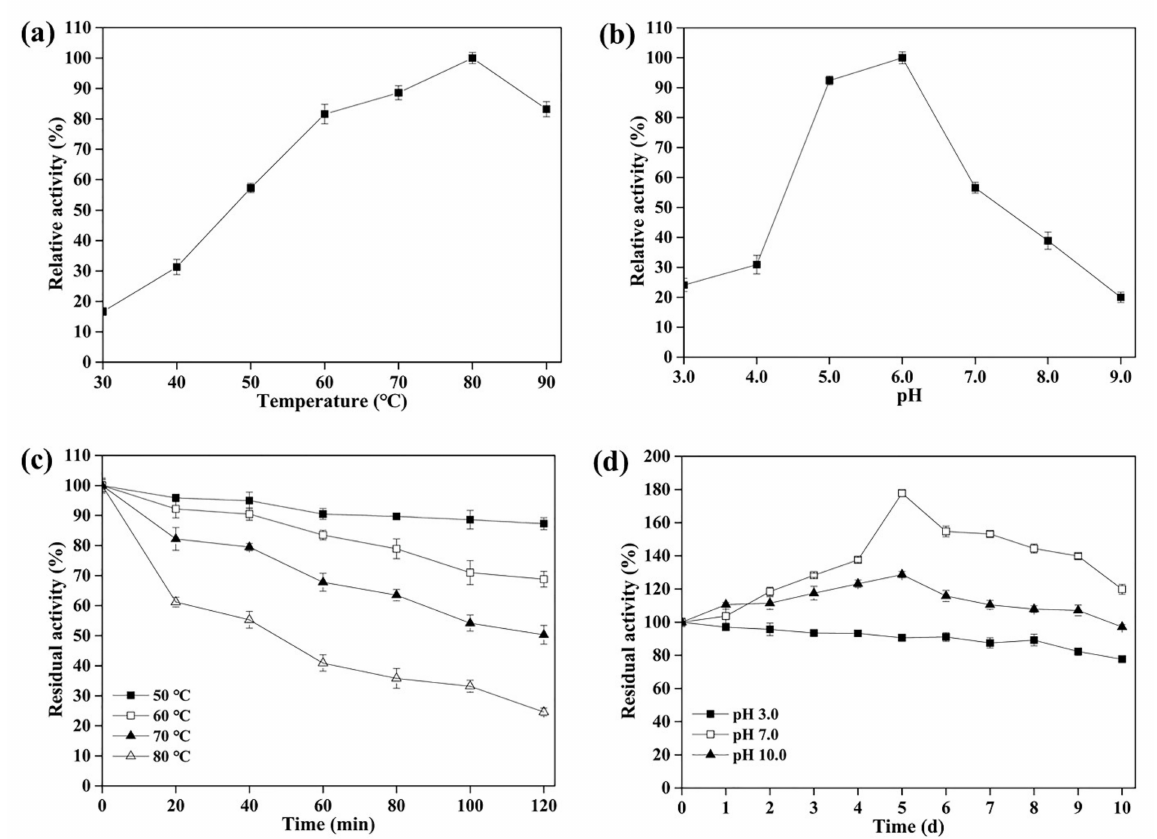
Figure 2. Effects of temperature or pH on the purified rLAC. ( a ) The laccase activity was recorded at different temperatures (30–90 ◦ C) and ( b ) pH values. ( c ) The thermostability of rLAC was evaluated through monitoring the residual activity after incubation at 50 ◦ C, 60 ◦ C, 70 ◦ C, and 80 ◦ C for different lengths of time (0–120 min). ( d ) The pH stability was investigated through measurements of its residual activity after incubation for different periods (0–10 d) at 4 ◦ C and pH 3.0, 7.0, and 10.0. All assays were conducted in triplicate, and the data were exhibited as mean ±